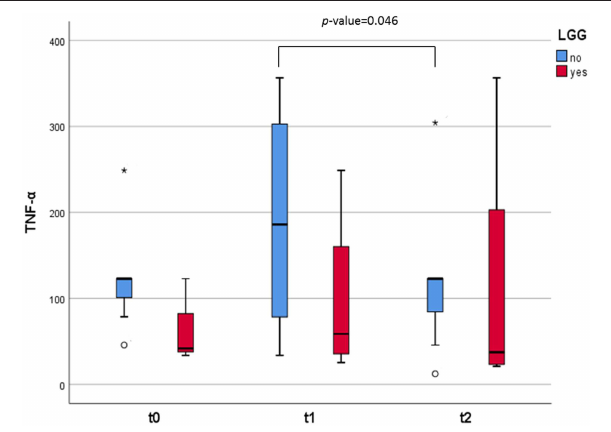
FIGURE 4 | Box and whisker plots representing the concentrations (in pg/g) of TNF- α excreted in the fecal samples. The infants were divided in two groups: those who consumed the probiotic GG ( n = 4, in red) and those who did not ( n = 8, in blue). The lines inside the rectangles indicate the medians and the whiskers the maximum and minimum values. The dots outside the rectangles are suspected outliers ( > 1.5 × interquartile ranges) while the asterisks designate extreme value ( > 3 × interquartile ranges). Comparisons were made with the Wilcoxon signed-rank test to examine the differences over time ( t = 0, t = 1, and t =